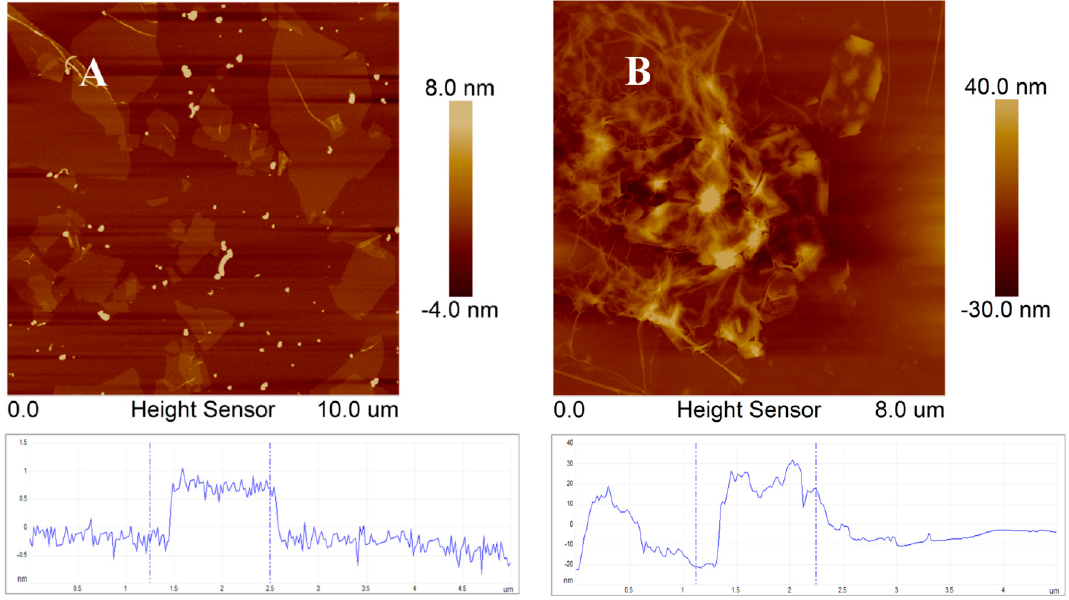
Figure 2. Atomic force microscopy (AFM) image of GO ( A ) and GO-NCNTs ( B ) from their dilute aqueous dispersion on freshly cleaned mica.